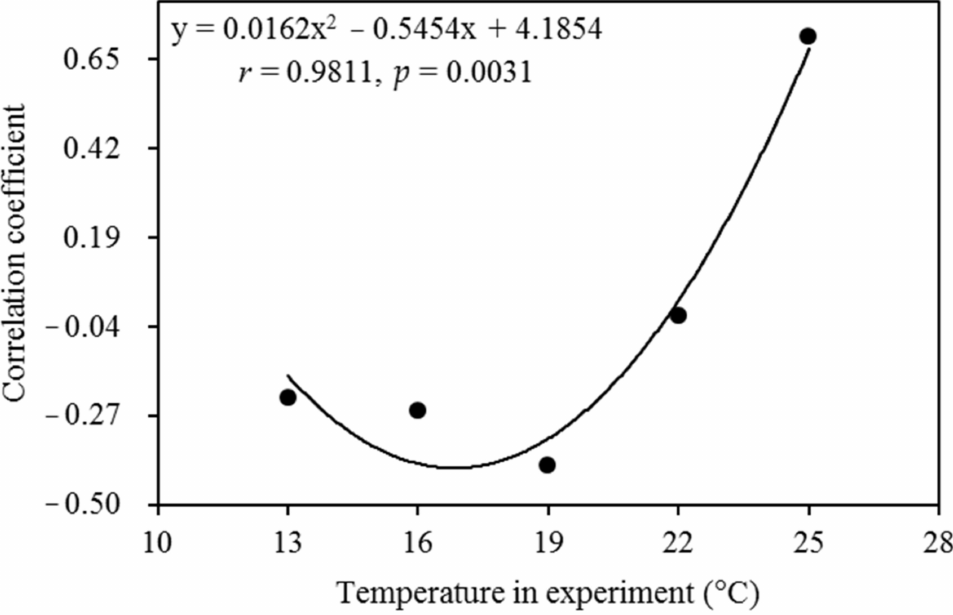
Figure 5. Impact of experimental temperature on the thermal adaptation of Phytophthora infes- tans. Thermal adaptation was quantified by analyzing the linear association (correlation coeffi- cient) between the aggressiveness of Phytophthora infestans and the annual mean temperature at its collection